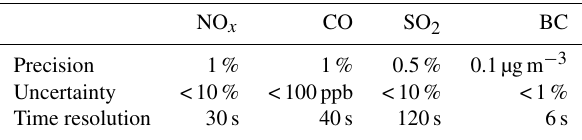
Table 1. Precisions and uncertainties of air pollutants analysers used in our experiments.